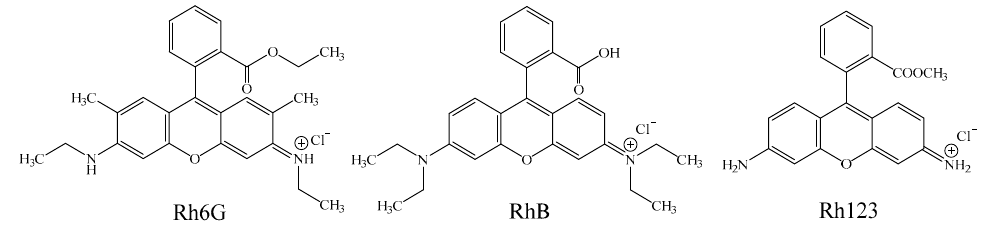
Figure 2. The structures of rhodamine dyes used in binary thiacalix[4]arene-dye systems.